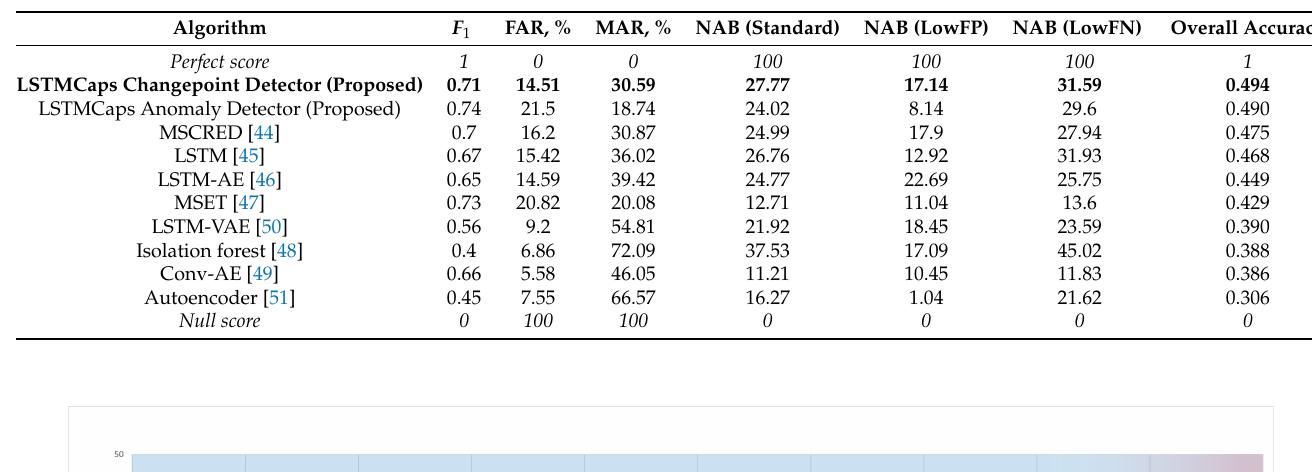
Table 12. Comparison of the best score out of five runs for each metric tested.